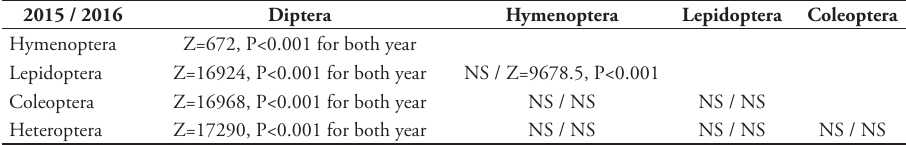
Table 2. Comparison (Wilcoxon test) of relative abundances of Hymenoptera trapped by Sarracenia hybrids in 2015 and 2016.